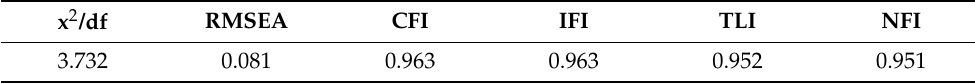
Table 5. Test of the degree of fit of perceived value consciousness model. x 2 /df